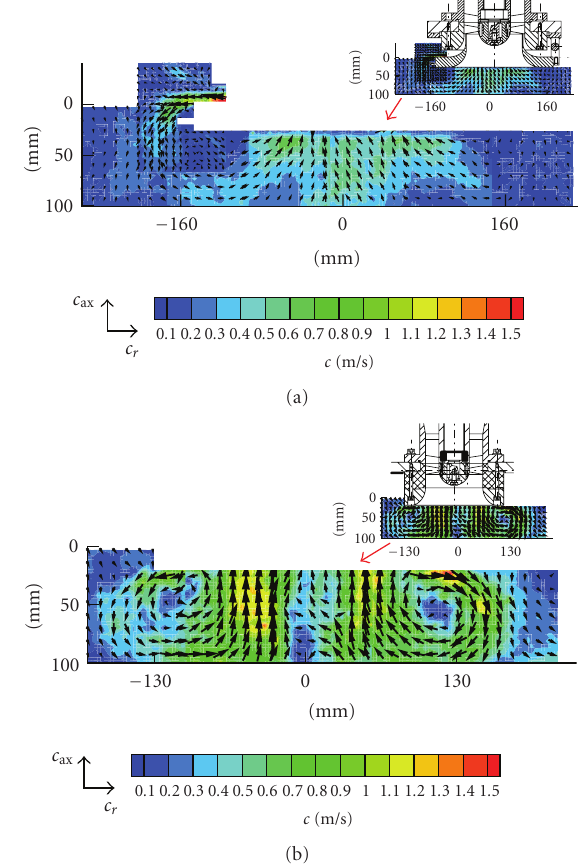
Figure 10: Inlet flow of the double-inlet-nozzle (a) and of the original casing (b) at stall conditions and discharge of the backflow at the gap in (a), Q/Q opt = 0 . 3, c = ( c 2